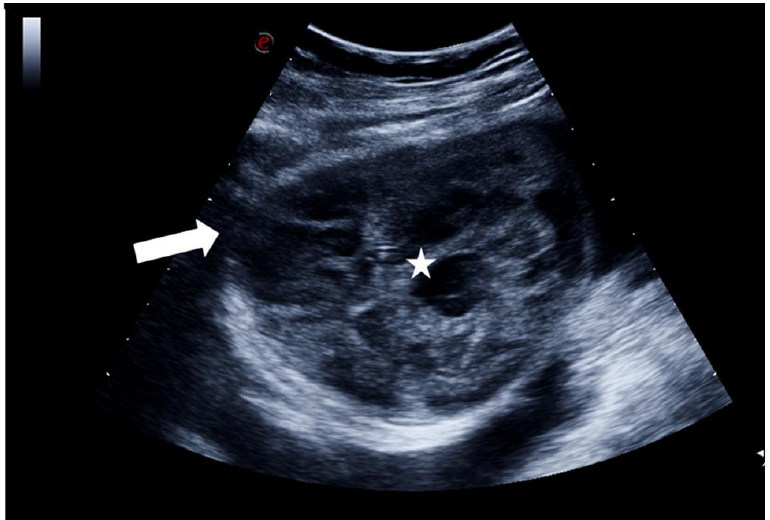
Figure 1. Foetal acalvaria; gray scale ultrasound of the foetal brain (3.5 mhz probe) in axial plane. Gestational age 38 weeks. No skull seen around the brain (arrow). Asterisk indicates the inter-hemispheric fissure